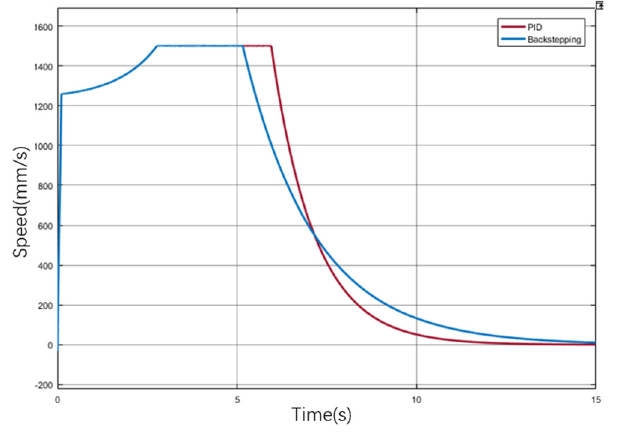
Figure 7. Comparison of speed curves of traditional PID and adaptive inversion controller.